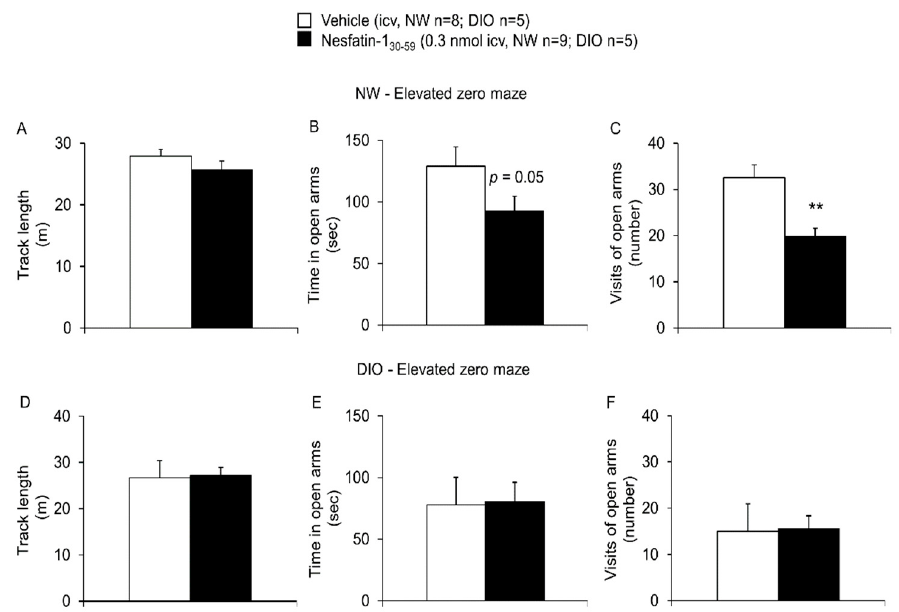
Figure 4. Nesfatin-1 30-59 induced anxiety in the elevated zero maze in normal weight but not in diet-induced obese rats. Intracerebroventricularly cannulated normal weight or diet-induced obese rats were injected with vehicle (5 µ L H 2 O, n = 8 and n = 5, respectively) or nesfatin-1 30-59 (0.3 nmol/rat in 5 µ L H 2 O, n = 9 and n = 5, respectively) at the beginning of the dark phase and 30 min later placed on a zero-shaped, elevated platform with two closed and two open zones. Behavior including visits of open arms (( A ): normal weight; ( D ): diet-induced obesity), time in open arms (( B ): normal weight; ( E ): diet-induced obesity) and track length (( C ): normal weight; ( F ): diet-induced obesity) were assessed for 5 min using a computer-supported technique. While a tendency in the time in open arms ( p = 0.05) and a significant reduction of the number of visits in open arms was observed in nesfatin-1 30-59 injected rats compared to vehicle, none of the parameters were affected in diet-induced obese rats. All data were distributed normally except for the time in open arms and visits of open arms in the DIO/vehicle group. For better comparability, all data are expressed as mean ± SEM. Data have been analyzed using the Mann–Whitney-U test (time in open arms and visits of open arms in DIO) or t -test (all other data). Abbreviations: DIO, diet-induced obesity; NW, normal weight. ** p < 0.01 vs. vehicle.